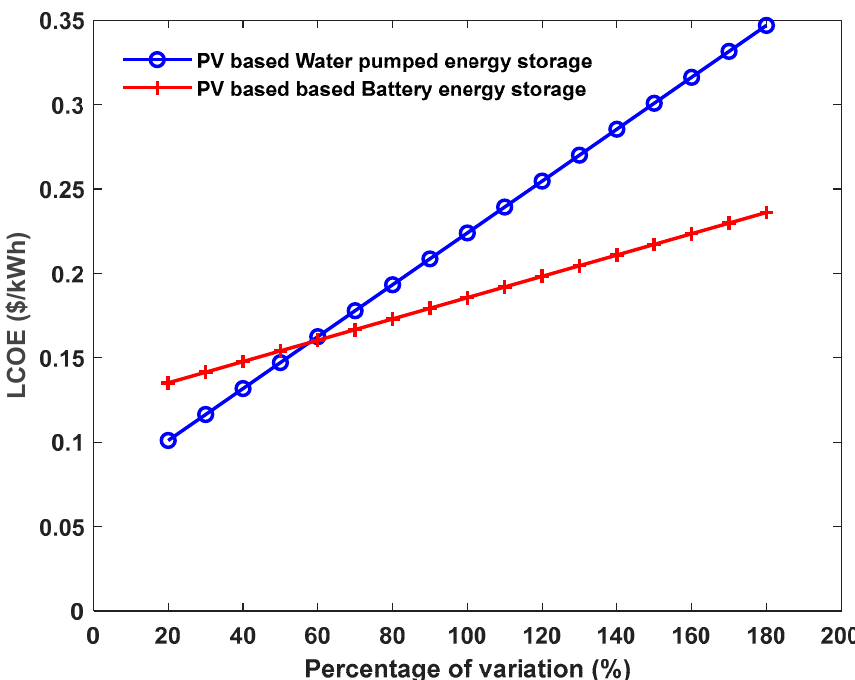
Figure 17. Influence of the variation of the cost of the energy storage system on the LCOE of the studied systems.